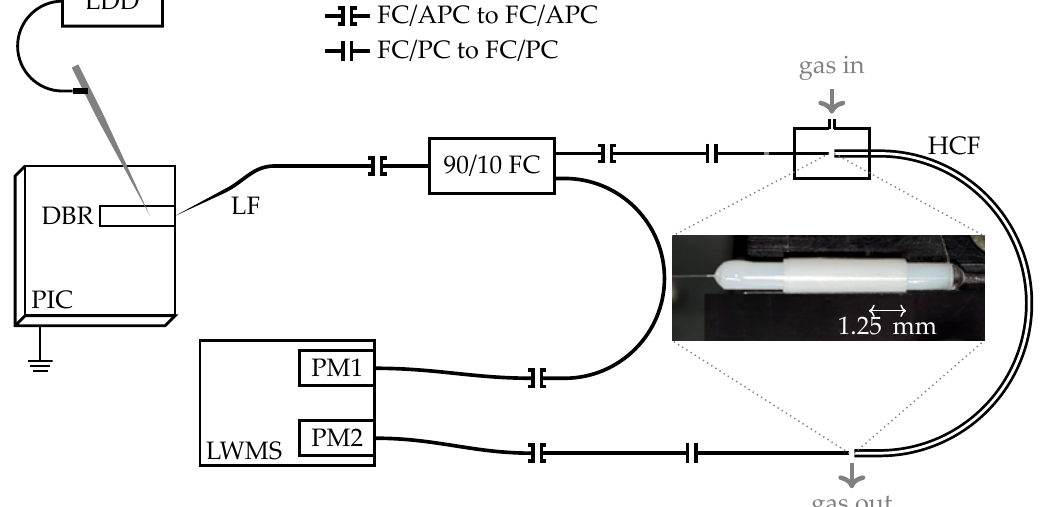
Figure 1. Sketch of the setup. The photonic integrated circuit (PIC) is grounded from the substrate side, whereas the laser diode driver (LDD) connects to the on-chip distributed Bragg-reflector (DBR) laser with a probe needle. The laser output is collected with a lensed fiber (LF) and split into two arms at the 90/10 fiber coupler (FC). 10% of the light is guided towards the power meter 1 (PM1) of the light wave measurement system (LWMS). The 90% light path connects to the roughly 1.65 m-long hollow-core fiber (HCF), which has a mechanical splice on each end to allow gas in/out flow. The mechanical splice is shown at the inset of the figure. Light that passed through the HCF is then guided towards the second power meter